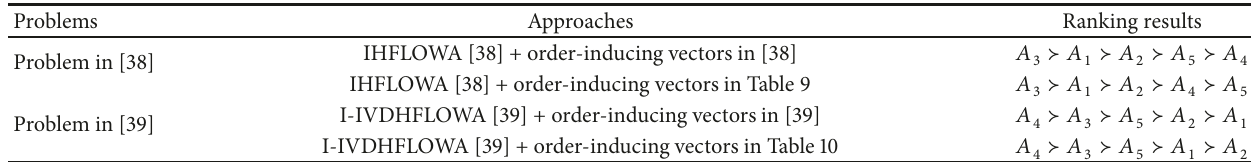
Table 11: Ranking results obtained by applying different order-inducing vectors to [38, 39].